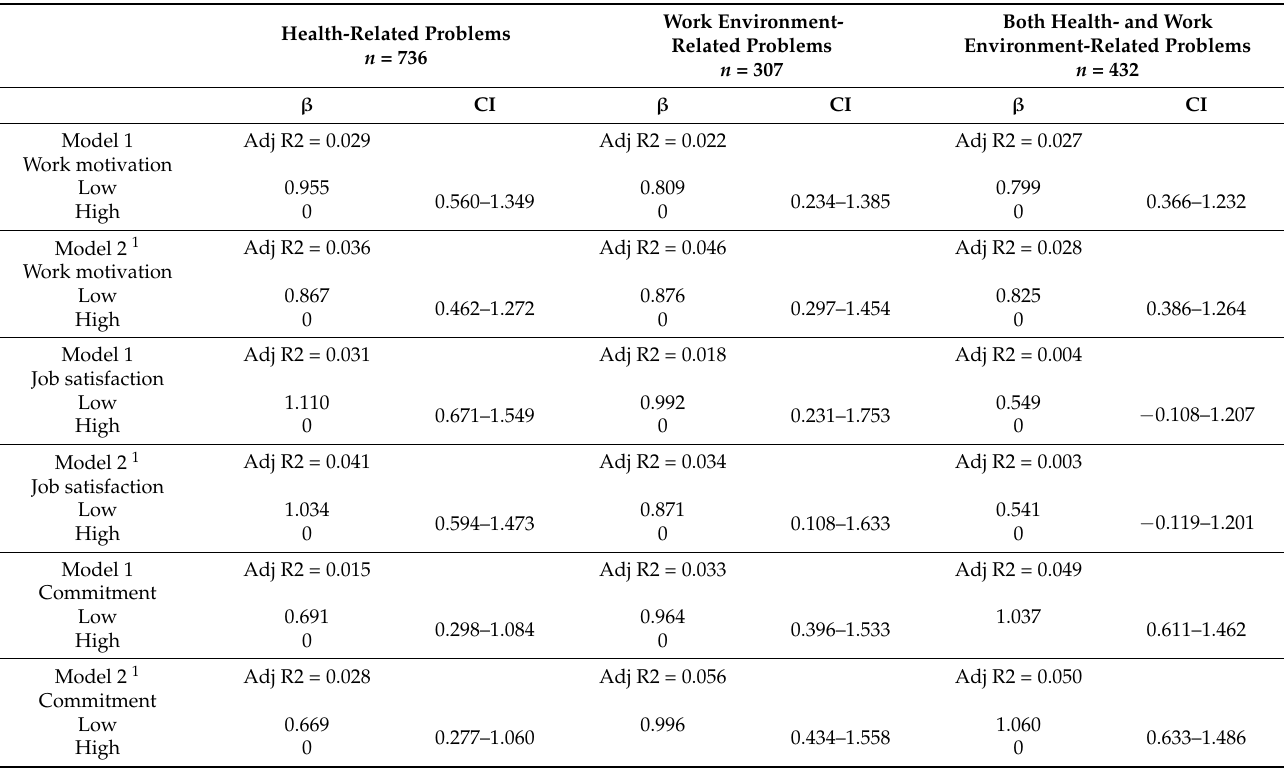
Table 3. Association between work motivation, job satisfaction and organisational commitment and productivity loss among employees who experience health-related problems, work environment- related problems or a combination of problems. Health-Related Problems n =